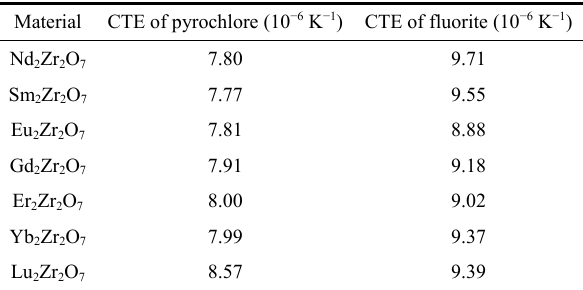
CTEs of rare-earth zirconate materials calculated by the molecular dynamics method [102]